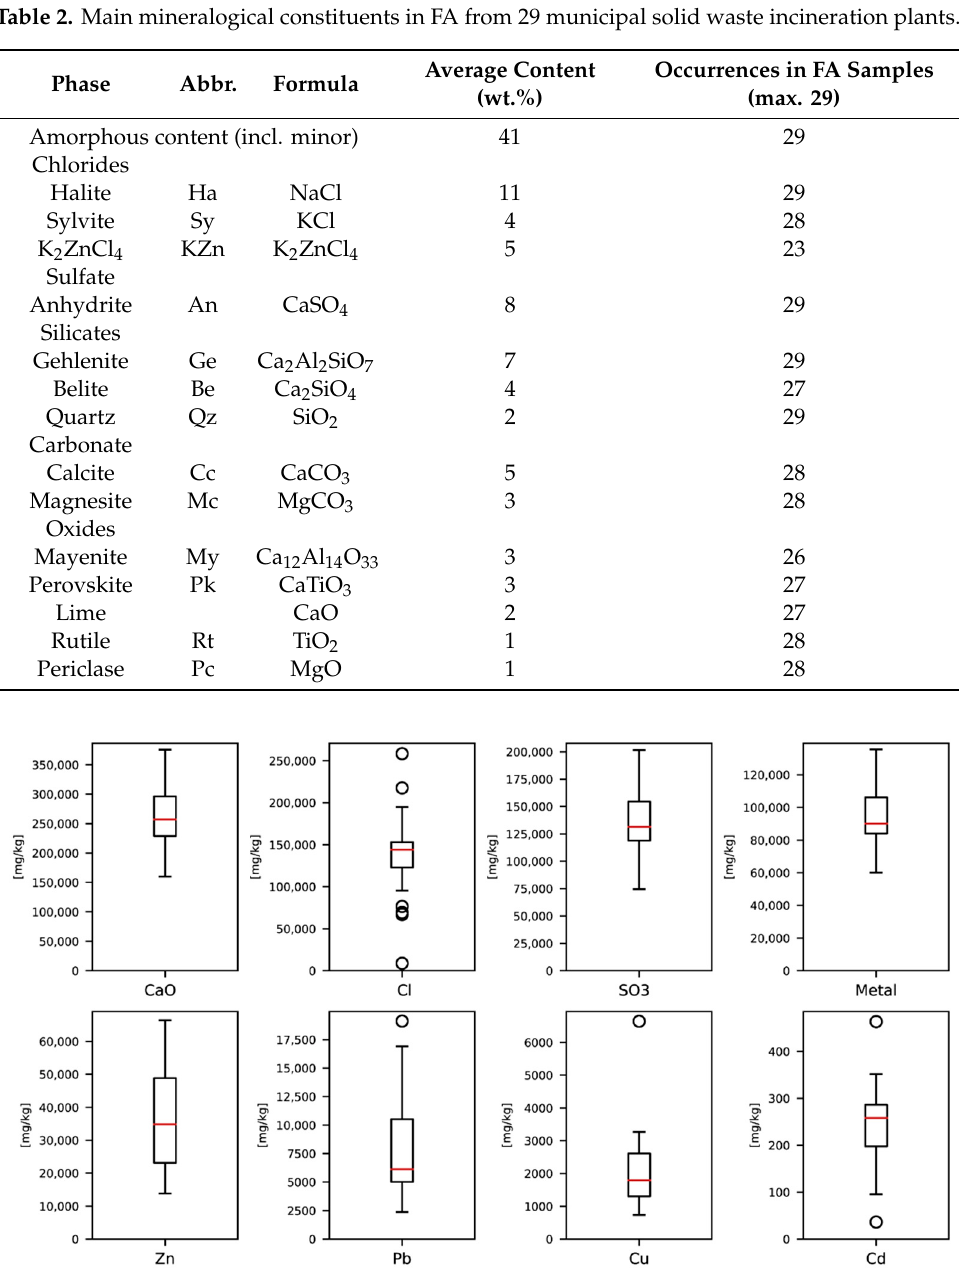
Figure 1. Concentration distribution of selected chemical constituents in the 29 Swiss fly ash (FA) samples.